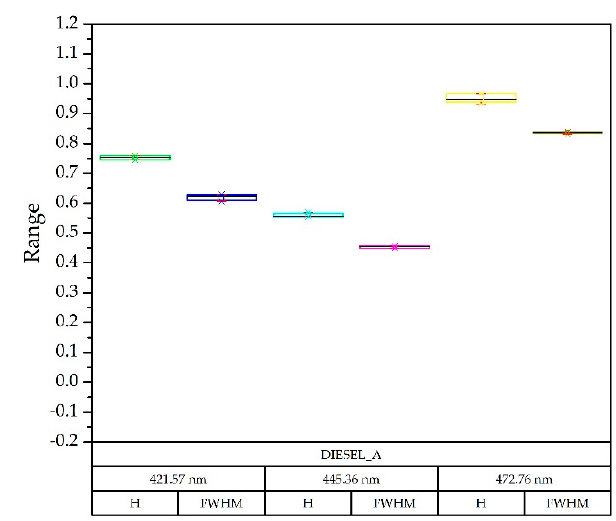
Figure 7. Box-plot diagram: comparison of the results obtained with the diesel A spectra with LED currents of 0.33, 0.44, 0.55 and 0.8 Amps, taking as reference the nominal current of 0.65 A. For each wavelength, the Gaussian in height (H) and width (FWHM—Half Width at Half Maximum) was identified.